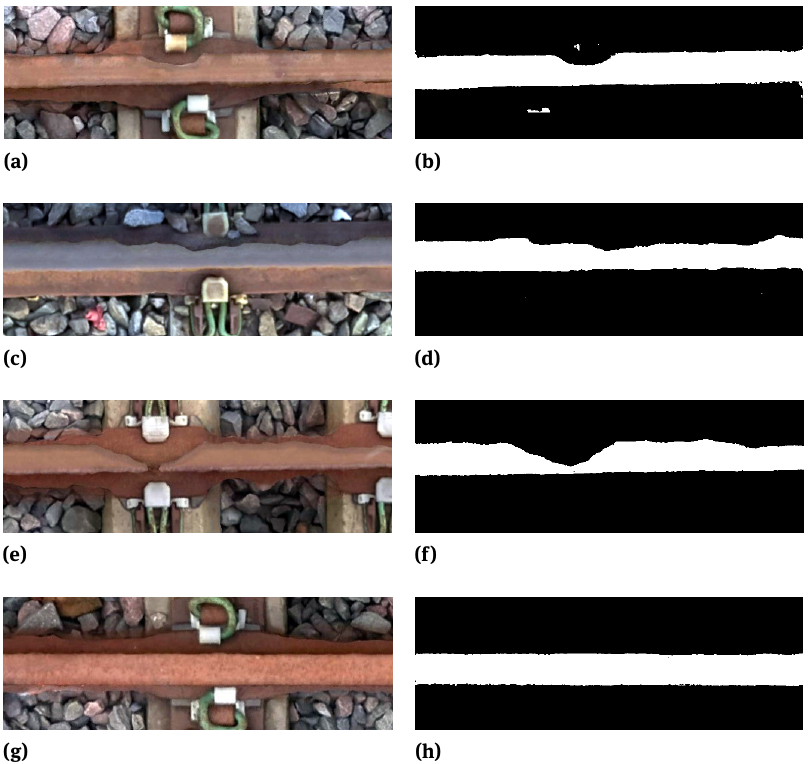
Figure 6: Track image segmentation effect by FCN-8 on data from data_test , a), c), e), g) show original track images, b), d), f), h) show corresponding track images after segmentation with